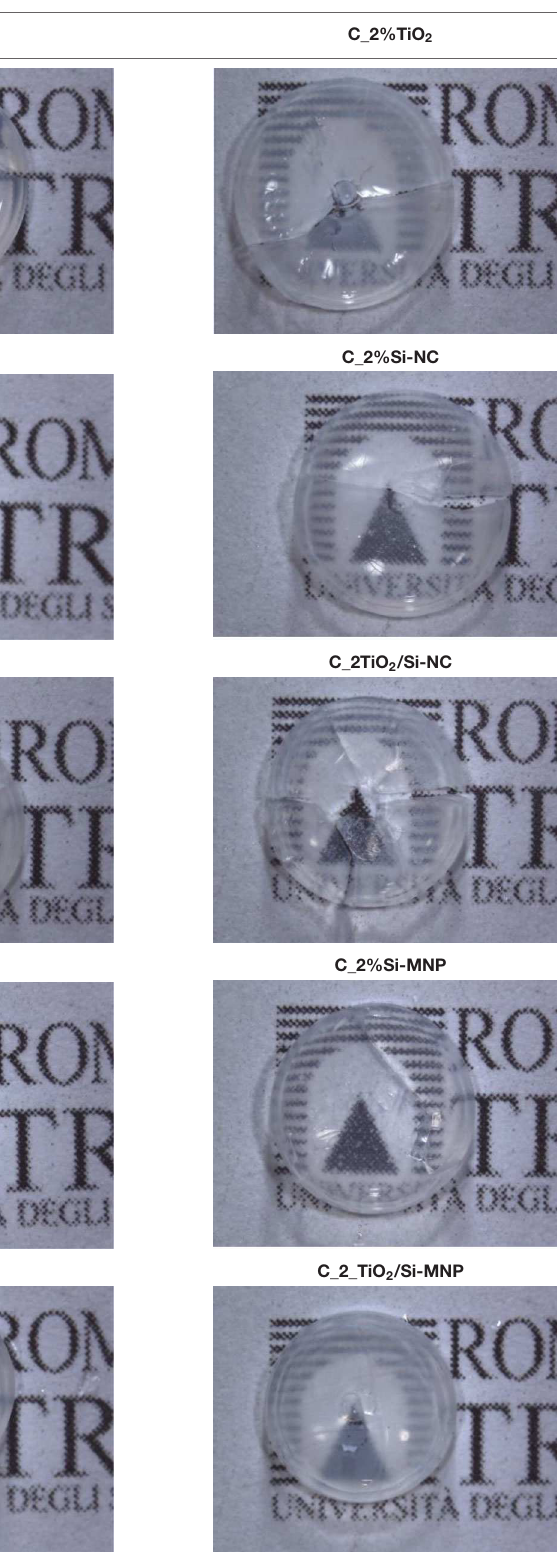
TABLE 2 | Hybrid coatings after drying under laboratory conditions for different concentration of Si-NC/Si-MNP and TiO 2